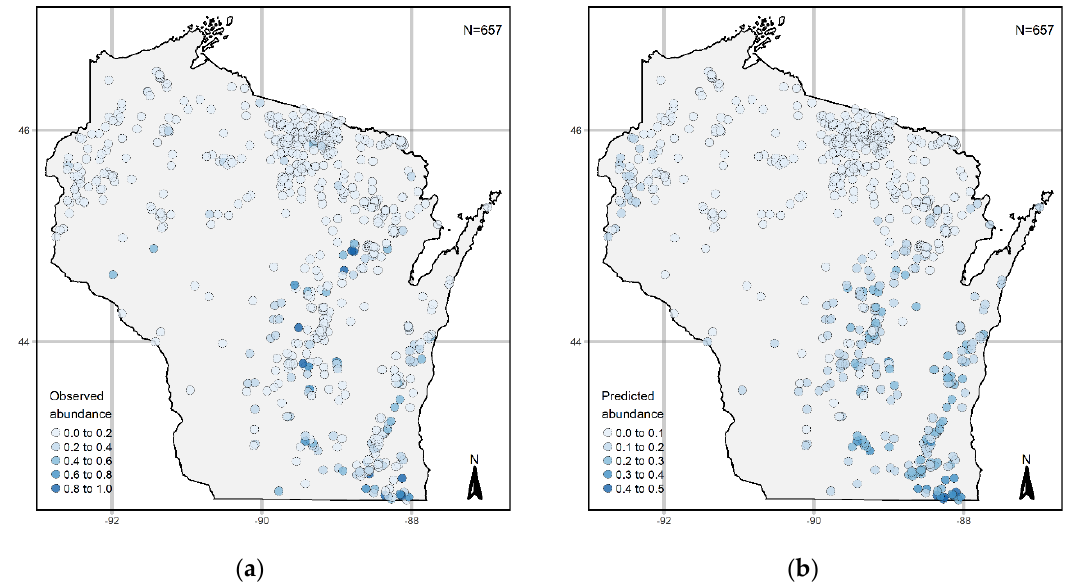
Figure 2. Eurasian watermilfoil abundance on N = 657 surveyed lakes. Maps depict abundance observed during aquatic plant field surveys ( a ) and predicted using beta regression ( b ).